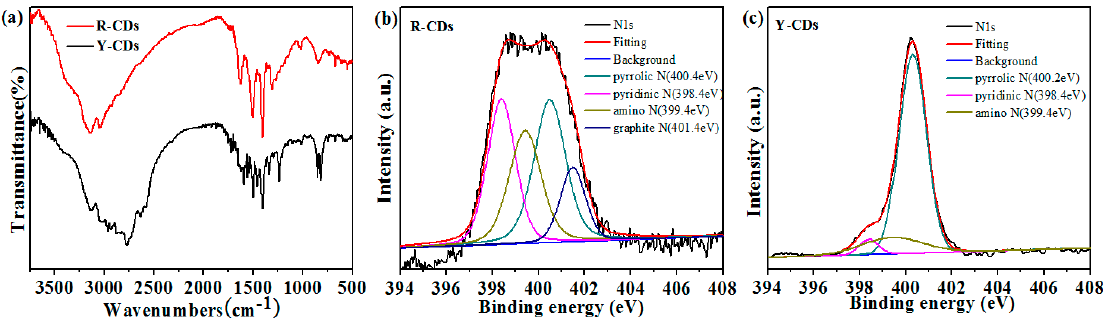
Figure 6. ( a ) FTIR spectrum of R-CDs and Y-CDs. ( b ) N1s spectrum of R-CDs. ( c ) N1s spectrum of